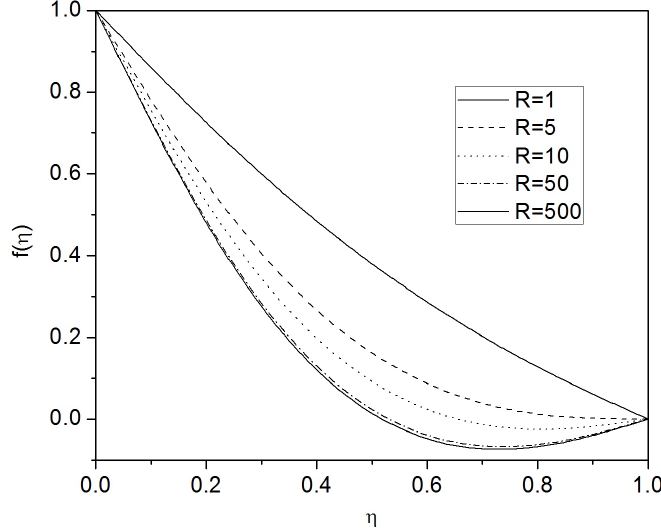
Fig. 4 Variations of f by increasing Reynolds number R .